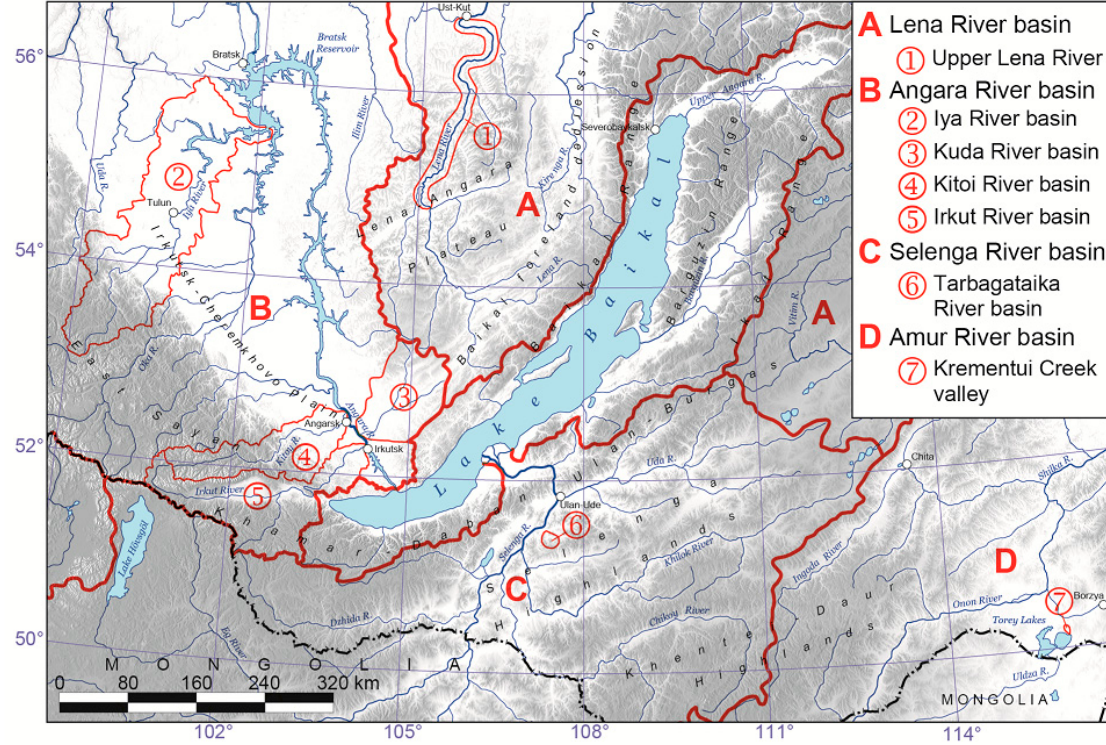
Figure 1. Location map of the basins of the Upper Lena ( A ), Angara ( B ), Selenga ( C ), and Upper Amur ( D ). The letters in the circles show the sub-basins of detailed studies.